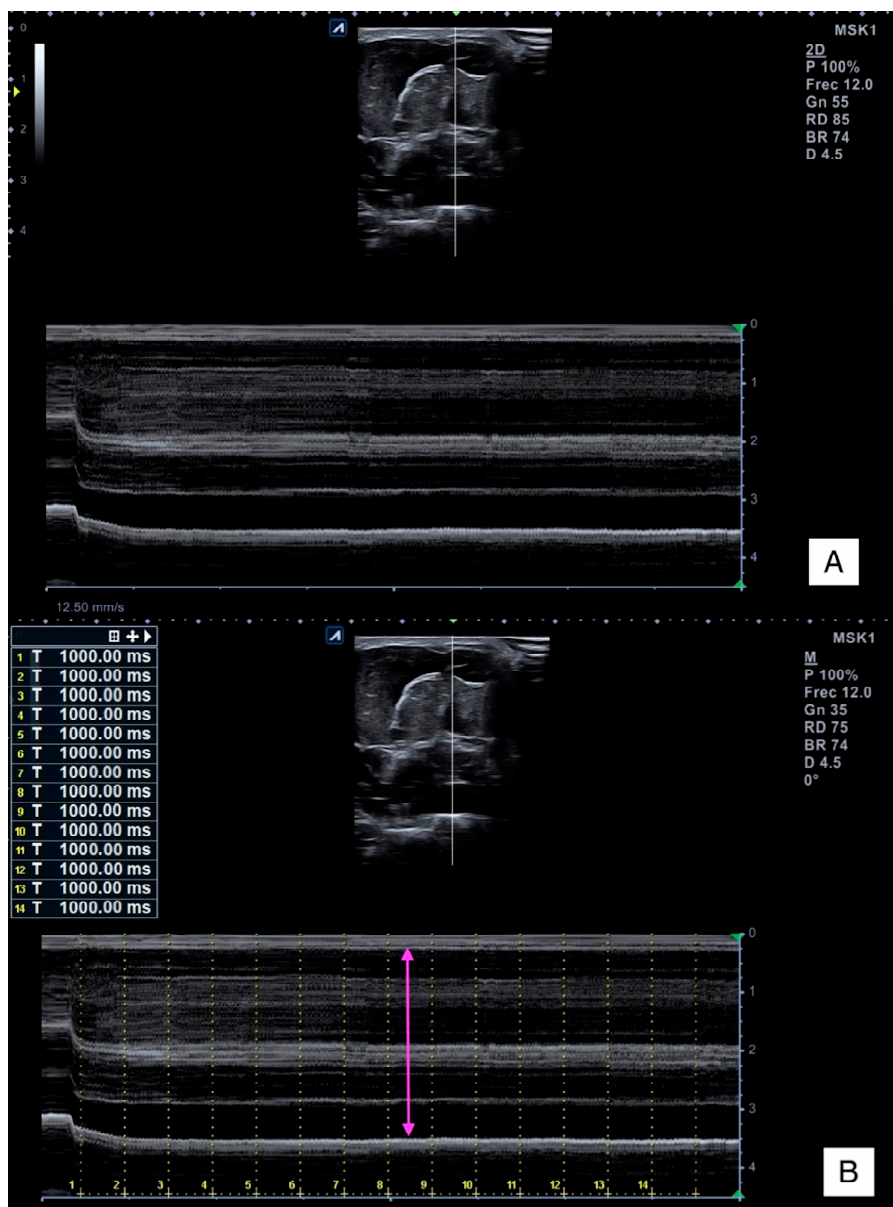
Figure 2. Raw M-mode ultrasound imaging ( A ) and thickness measurement ( B ).